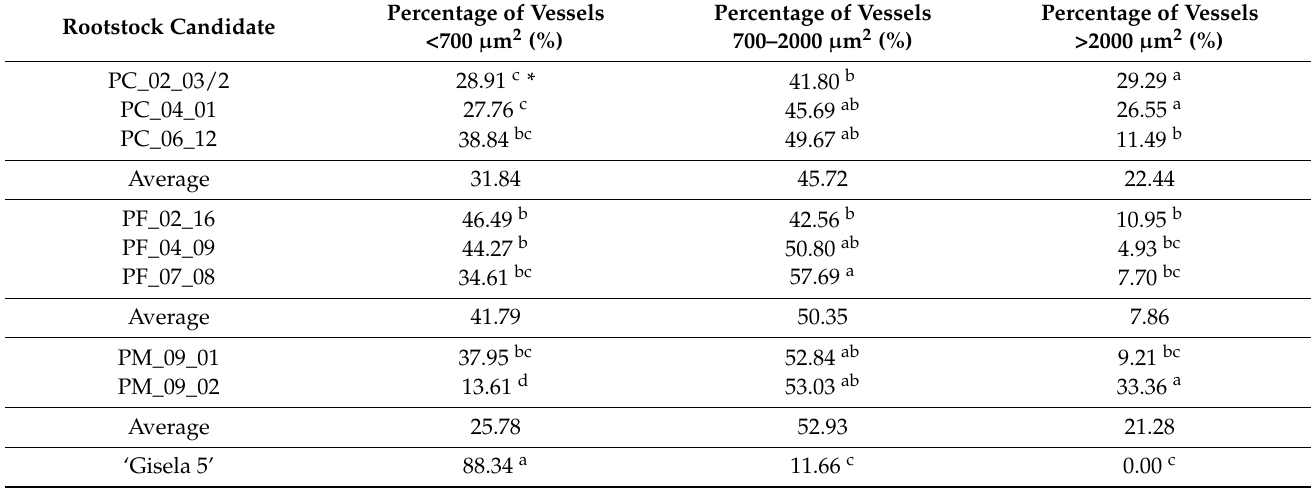
Table 3. Percentage of different vessel size-classes in the root secondary xylem of the examined cherry rootstocks, belonging to Prunus cerasus (PC), Prunus fruticosa (PF), Prunus mahaleb (PM), species and control ‘Gisela 5 (cid:48)